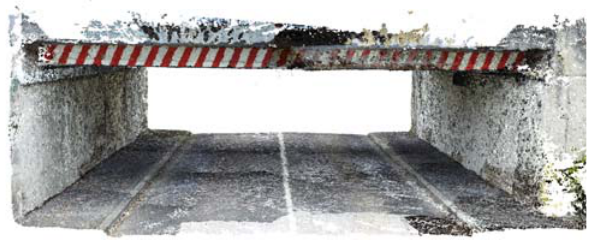
Fig. 4: Point cloud of the